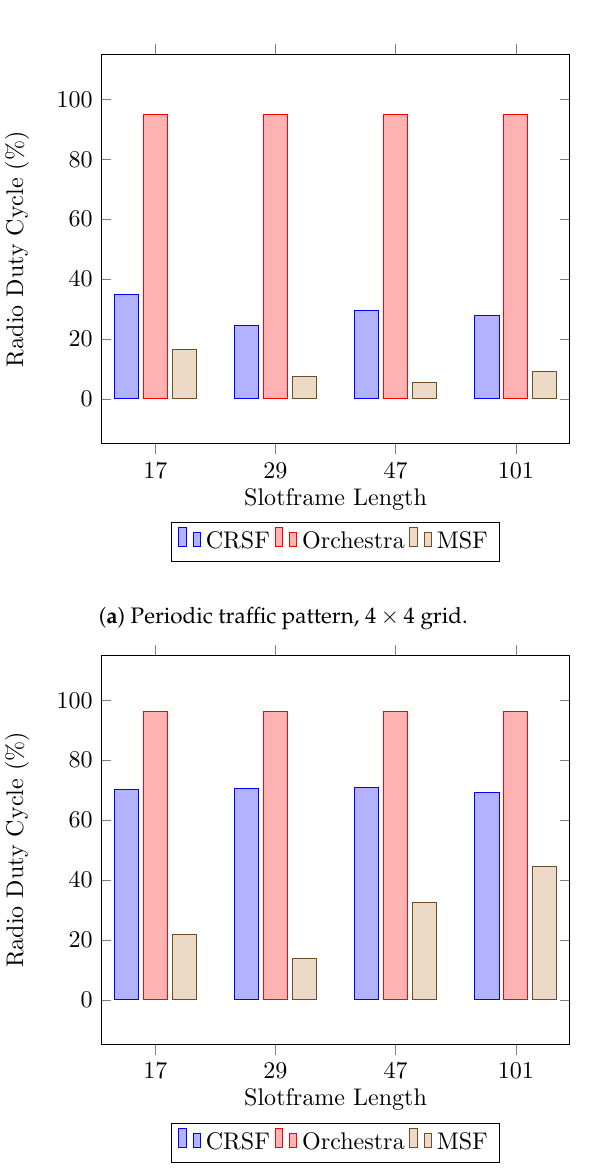
( a ) Periodic traffic pattern, 4 × 4 grid. ( b ) Periodic traffic pattern, 5 × 5 grid.